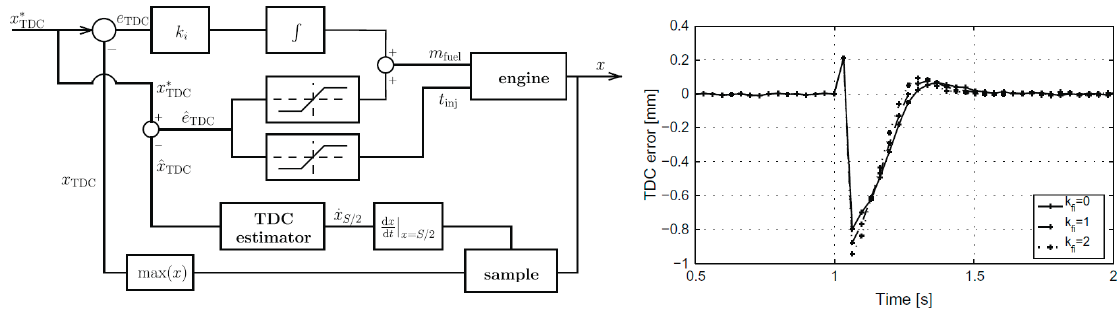
Figure 31. Virtual crankshaft of Minnesota University and displacement trajectory tracking results [33].